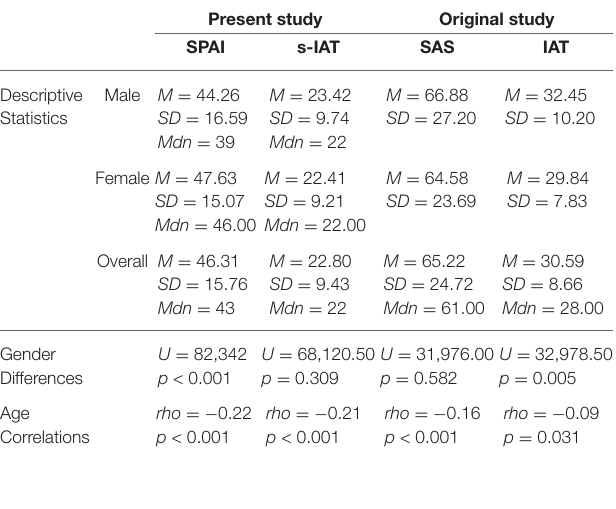
TABLE 2 | Common personality relationships to short internet addiction test (s-IAT)/smartphone addiction inventory (SPAI)